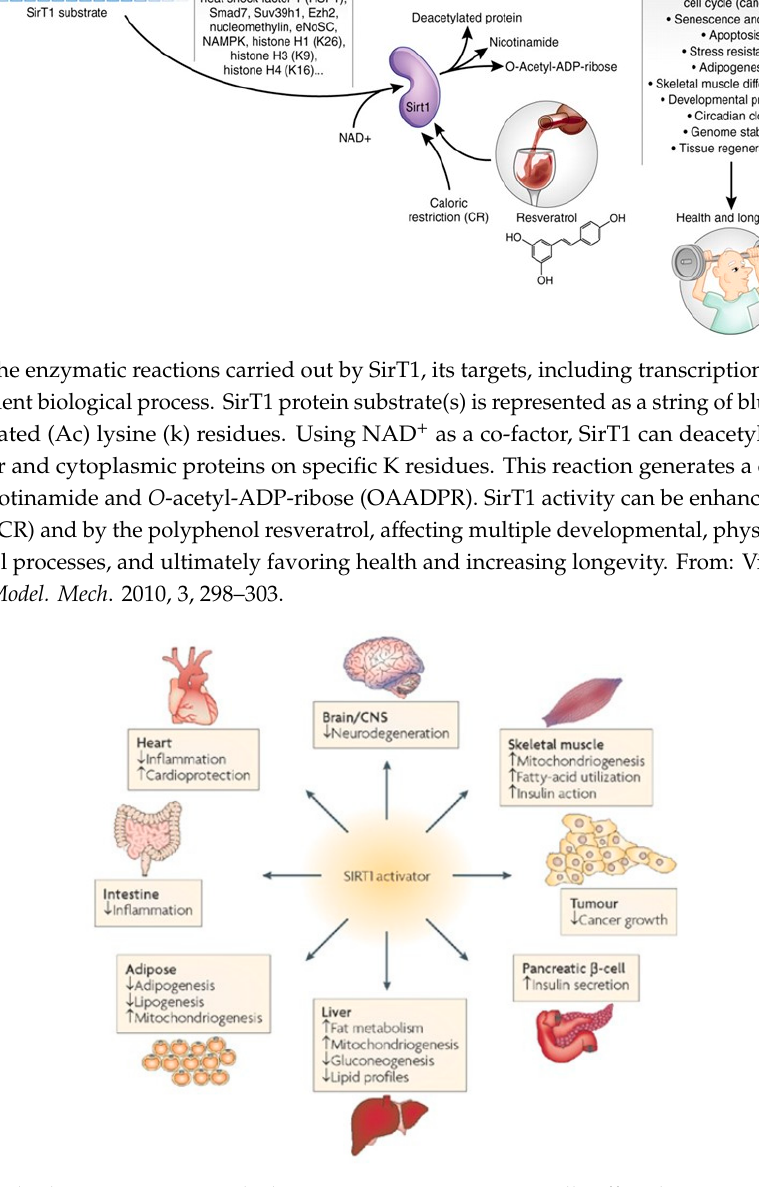
Figure 9. Multiple target organs in which SIRT1 activators can potentially affect the treatment of diseases of ageing. From: Sirtuins—novel therapeutic target to treat age-associated diseases Siva Lavu, et al. (2008) Nature Review Drug Discovery 7, 841–853, doi:10.1038 /